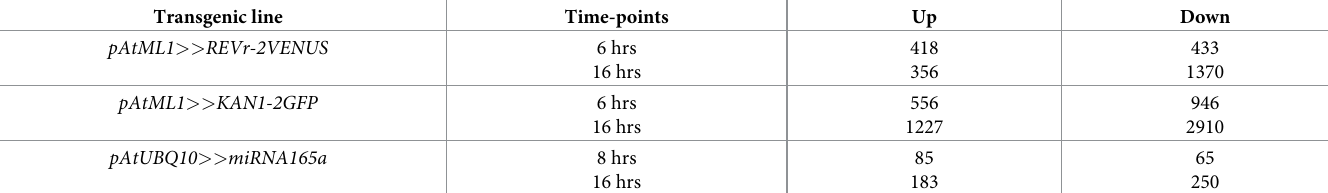
Table 1. Summary of the number of DEGs identified in various RNA-Seq experiments in different transgenic lines. Transgenic